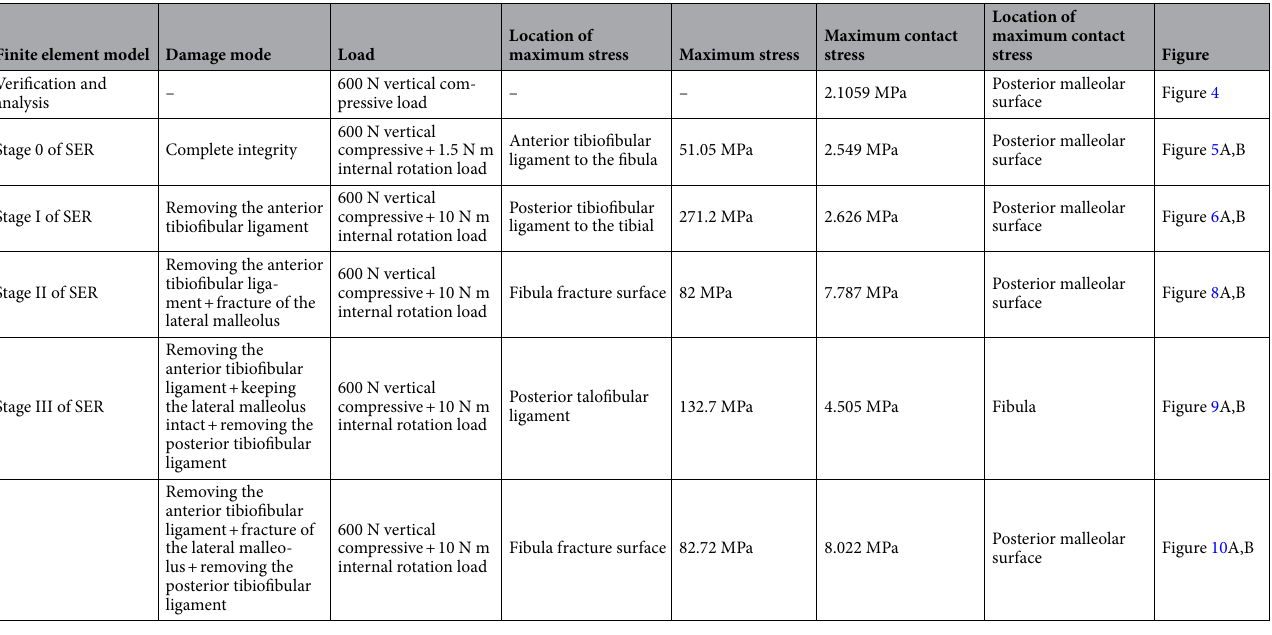
Table 3. Results of the finite element analysis.